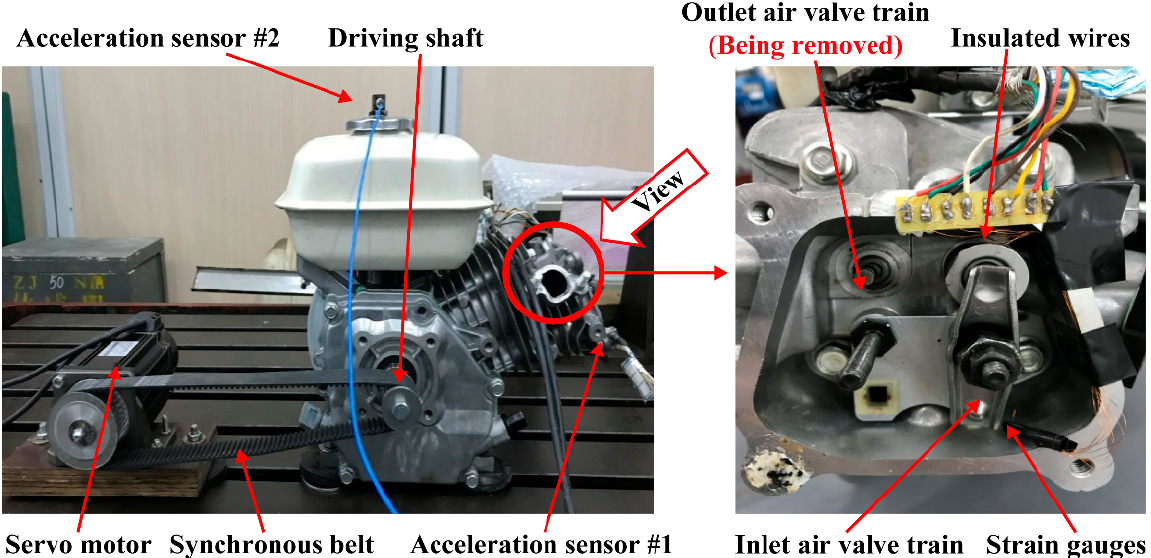
Figure 3. Arrangement of the test rig for measuring housing vibration and pushrod stress.